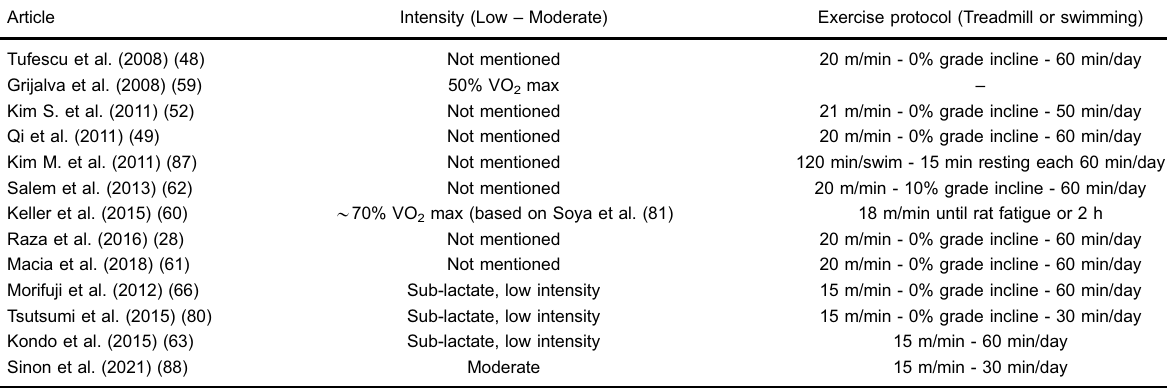
Table 1. Exercise protocols used in each study and the physical intensity mentioned.